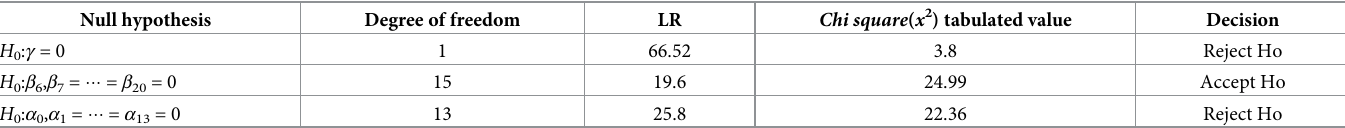
Table 4. Summary of hypothesis testing for the assumption of the stochastic frontier